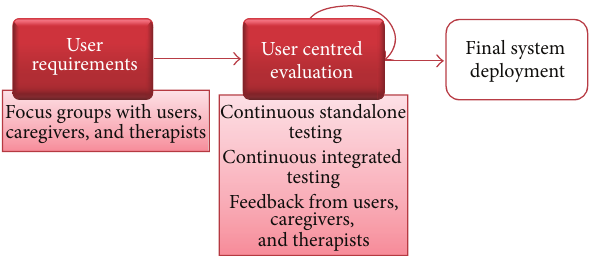
Figure 2: The adopted user centred design (UCD) approach.